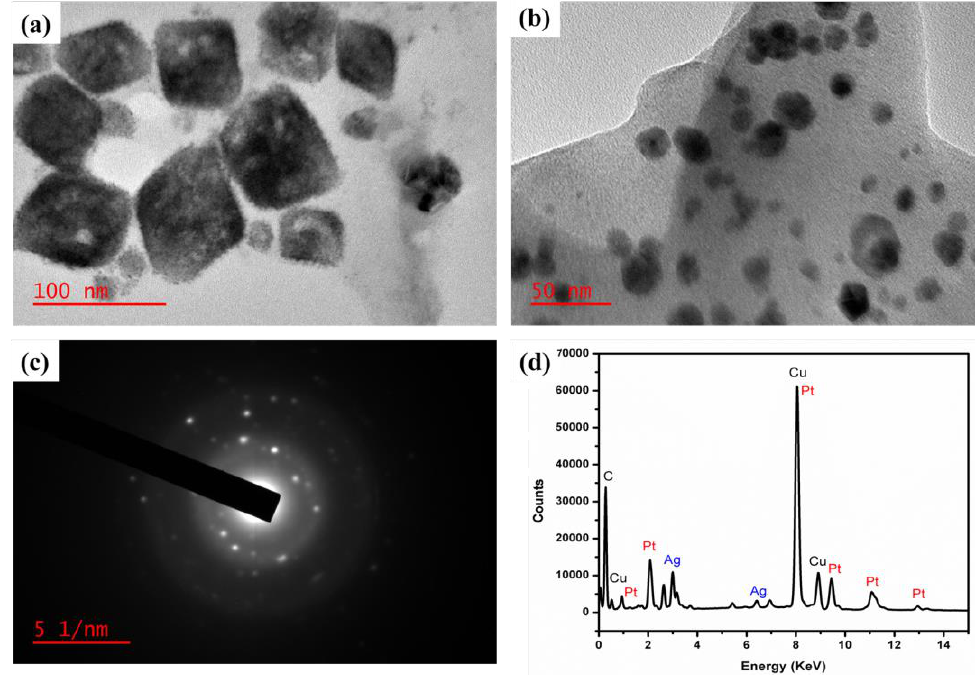
Figure 3. TEM images showing the morphology of ( a ) w -Pt@AgNPs and ( b ) e -Pt@AgNPs, SAED ( c ), and EDS spectra ( d ) of w -Pt@AgNPs.